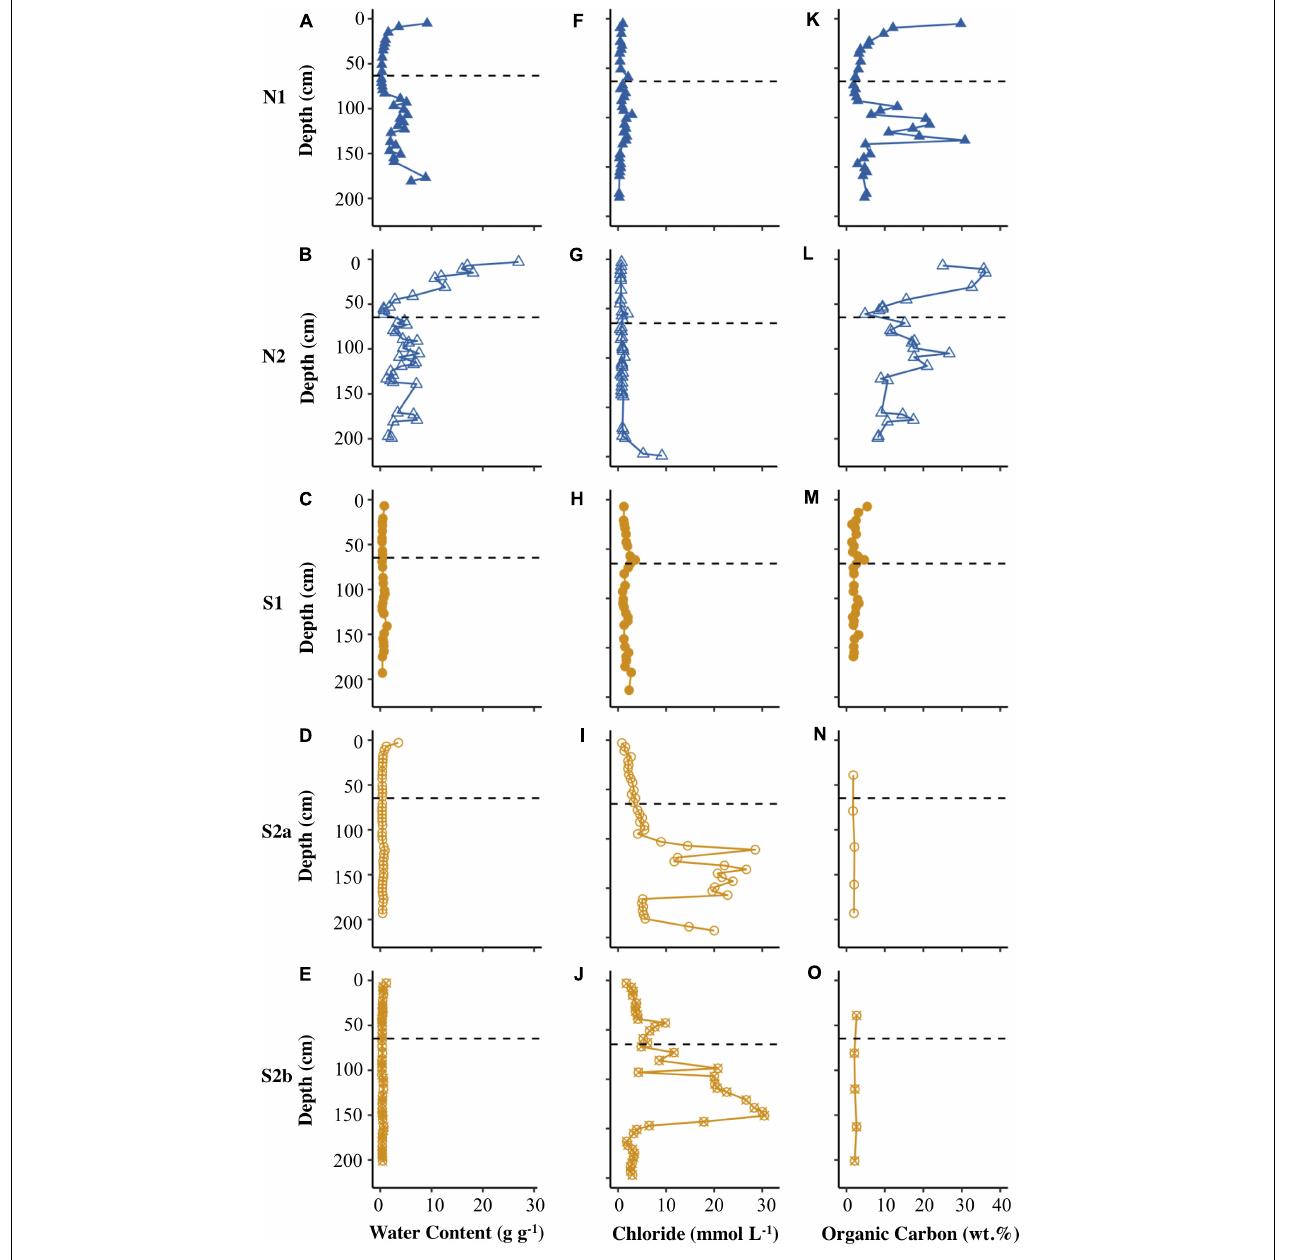
FIGURE 2 | Depth profiles of water content (A–E) , chloride concentration (F–J), and concentration of organic carbon (K–O) for N1, N2, S1, S2a, and S2b. The horizontal dashed line on each plot represents the base of the active layer in